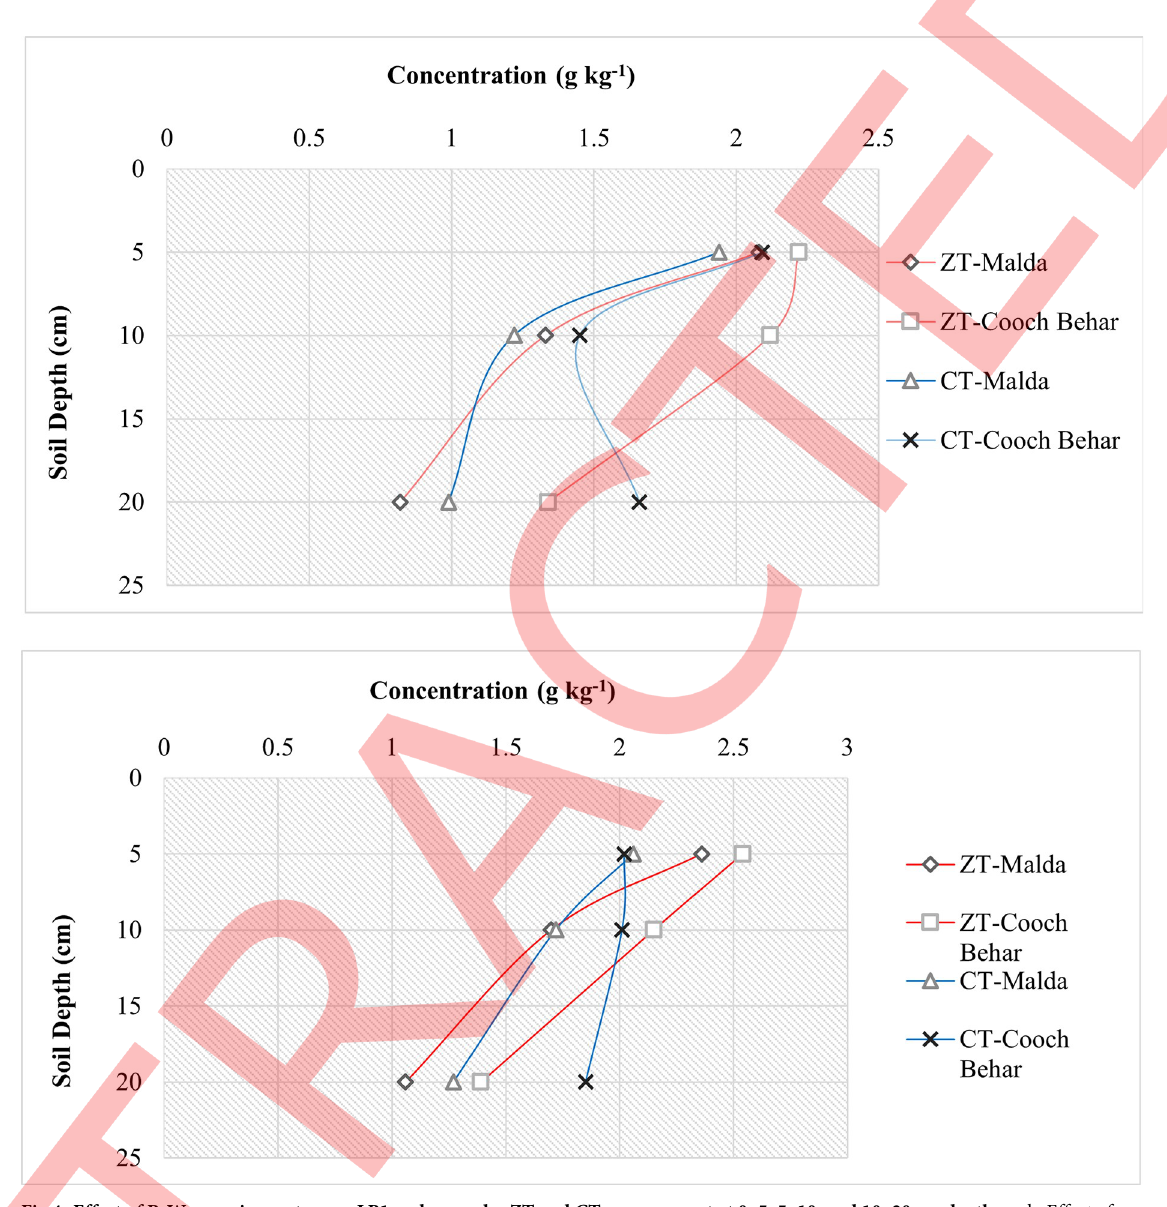
Fig 4. Effect of R-W cropping system on LP1 carbon under ZT and CT management at 0–5, 5–10, and 10–20 cm depths. a. b. Effect of R-M cropping system on LP1 carbon under ZT and CT management at 0–5, 5–10, and 10–20 cm depths.